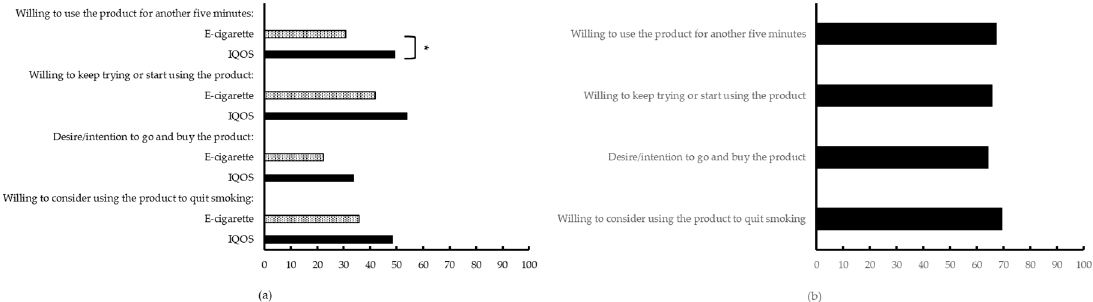
Figure 5. Additional VASs on Day 3. ( a ) Preferences for e-cigarette and IQOS TM , separately, with 0 being “ Not at all ” and 100 “ Very much so ”; ( b ) Product preference with 0 being “ E-cigarette ” and 100 being ” IQOS ”; for both (a and b) * p < 0.05.